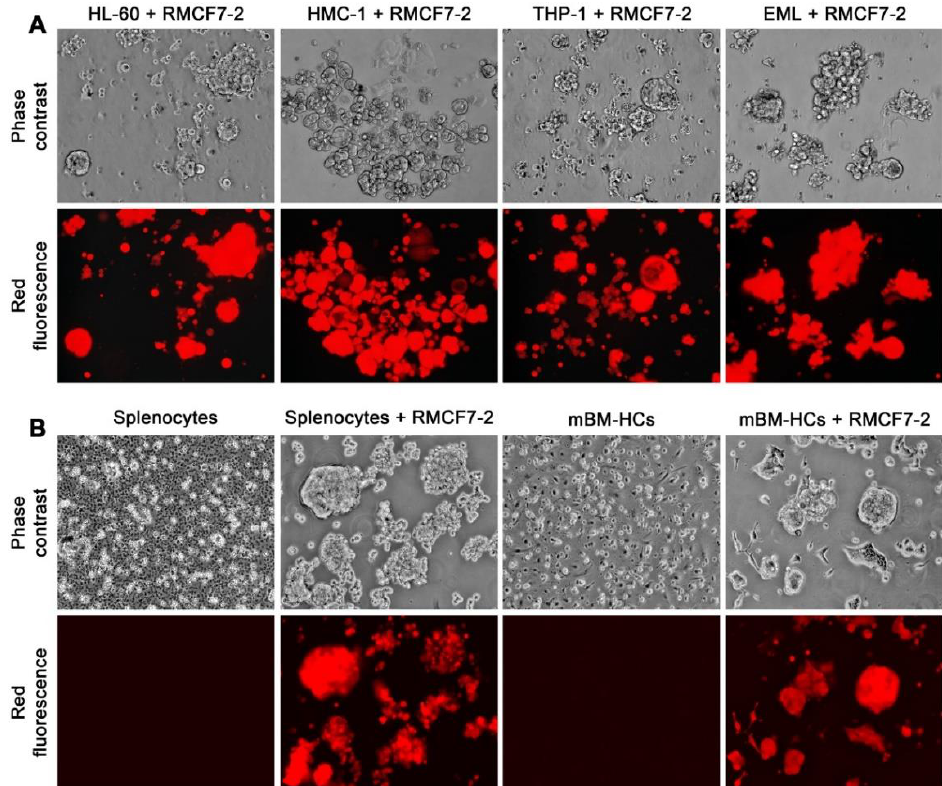
Figure 3. Suspension growth as an innate or programmed response. Similar morphology and growth behavior changes in RMCF7-2 cells after 28 days of co-culture with different types of HCs. Representative results are shown at 100× magnification. ( A ) Similar changes in co-cultures with varying lines of HCs. In these studies, HCs in the co-culture were killed by a 2-week G418 treatment. ( B ) Similar changes in co-cultures with murine splenocytes or mBM-HCs for 14 days. In these studies, mono-cultures of splenocytes and mBM-HCs were used as control. HCs in these co-cultures were not removed by G418 treatment.